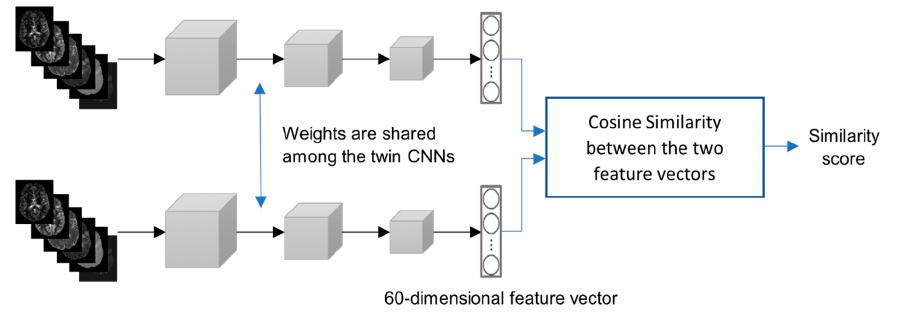
Figure 4. Classification model architectural diagram.